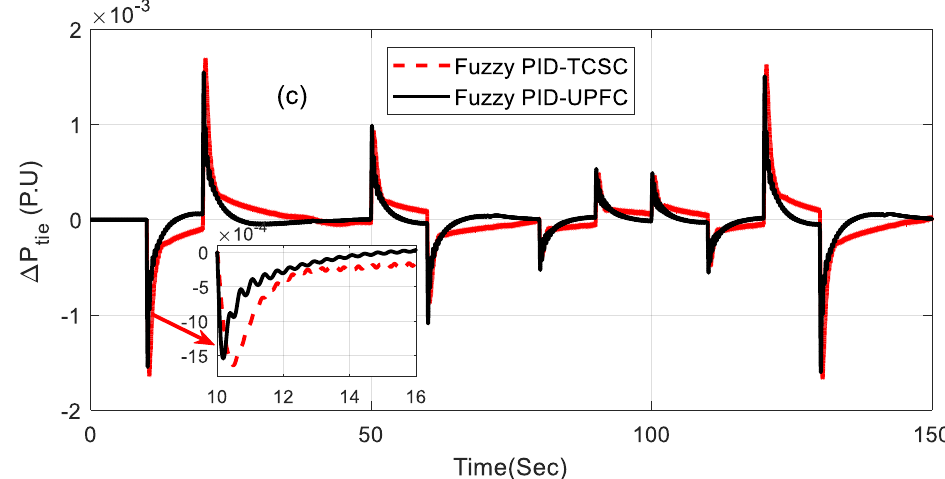
Figure 11. ( a – c ) Responses under step load variation.